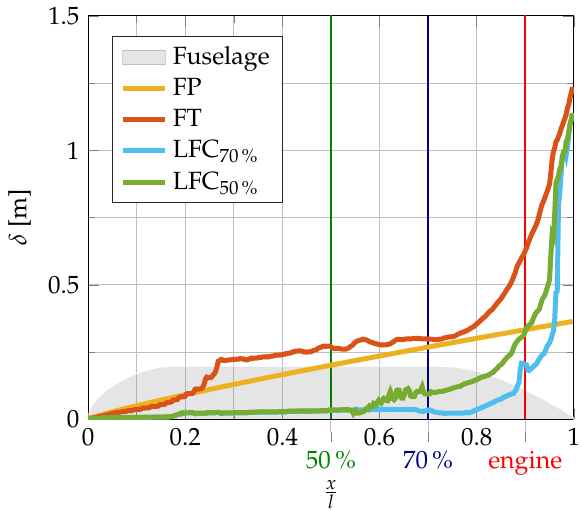
Figure 6. Boundary layer thickness δ over relative fuselage length x Fuselage shape plotted non-proportionally for illustration.